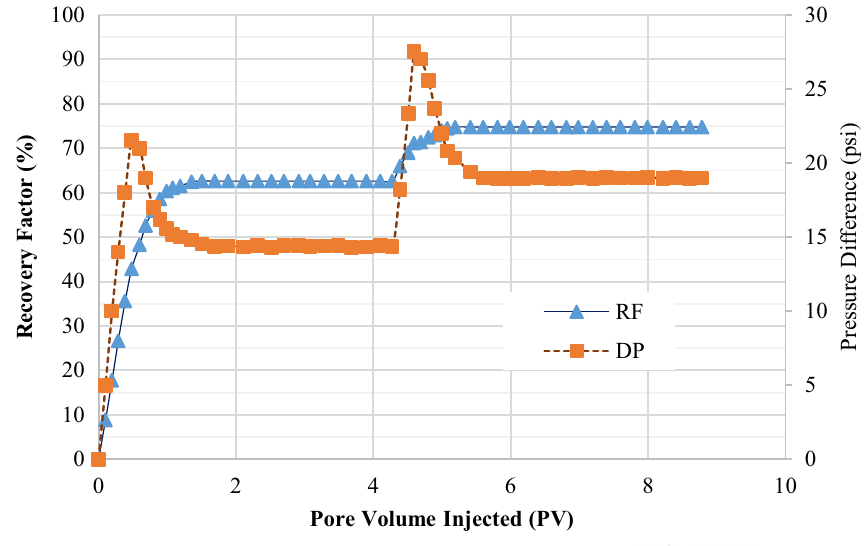
Fig. 9 Recover factor and pres- sure difference for injection of SW and SW.10D in test #3 at 90 °C and 1000 psia. Almost 12% additional oil recovery is recorded as a result of 10-times diluted SW after injecting SW. Also, higher pressure drop is observed in the second cycle